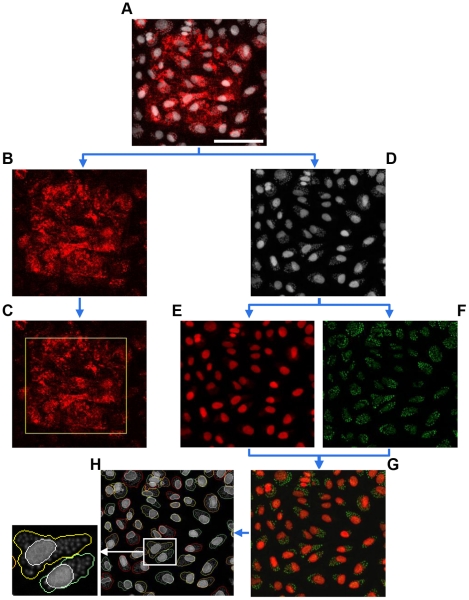
Microarray screening image analysis.Schematic illustration of how the developed software recognized the siRNA spot, the cells and the parasites for subsequent measurements. (A) All images of the T. cruzi primary screening were acquired in two different channels, as shown in (B) and (D). (B and C) Optically addressable siRNA spots were labeled with siGLO Red to enable their localization on the arrays. (D) Cell and parasite nuclei were stained using DRAQ5. As the raw images were acquired in a single wavelength, cells and parasites were artificially separated and emphasized in different colors (E and F, respectively), generating artificial two-wavelength images (G). This allowed for individual cell detection and quantification of several independent descriptors to measure infection (H). An enlarged panel showing cell detection by the software in greater detail is in the bottom left. The cell nuclei and boundaries are outlined in white and yellow/green, respectively (arbitrary colors). Scale bar represents 150 µm.